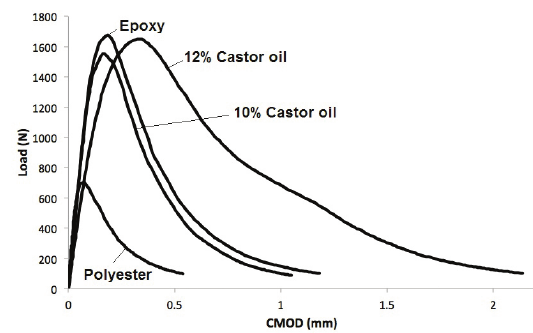
Figure 3. Typical Load vs. CMOD of castor oil and synthetic polymer mortars.